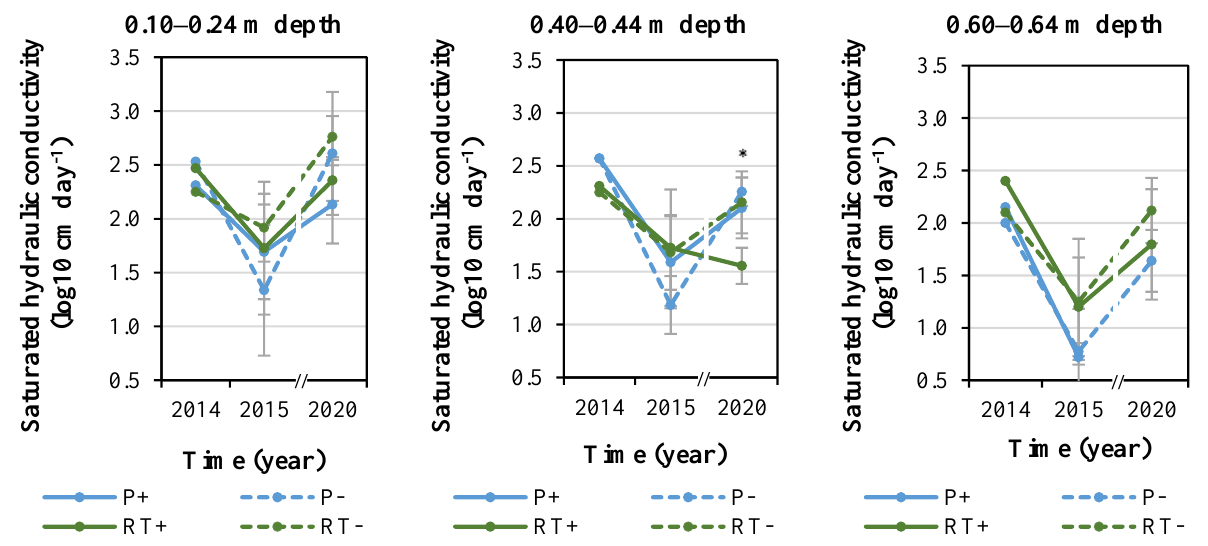
Figure 2. Geometric means of saturated hydraulic conductivity (log10 cm day − 1 ) in 2014, 2015, and July 2020 for depths of 0.10–0.24, 0.40–0.44, and 0.60–0.64 m. P: plow, RT: reduced tillage, +/ − : with and without compost, ± standard deviation. Note: in 2020, P+ corresponding to depth of 0.60 m is missing; in 2014 the standard deviation is not available. * Significant effects between treatments with p < 0.05 (Tukey’s HSD, refer to the Text for details).